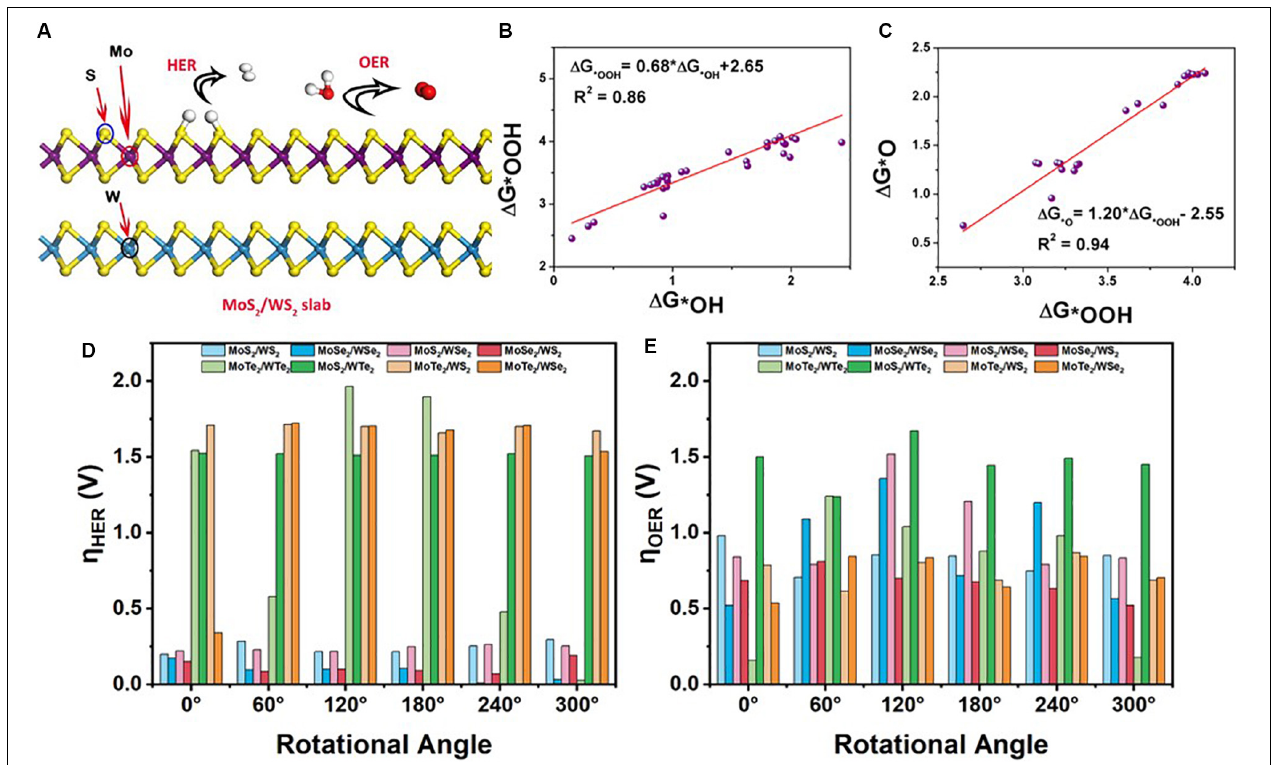
FIGURE 7 | (A) Schematic diagram of the heterostructure configurations for overall water splitting. (B,C) The linear relationships between adsorption free energies. (D,E) The relationships of the rotational angle with η HER and η OER for each system. Reproduced from Ge et al. (2020) with permission from Copyright (2020) American Chemical